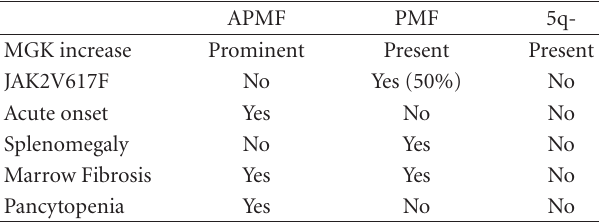
Table 1: The basic characteristics that help in the di ff erential diag- nosis of APMF (acute panmyelosis with myelofibrosis), PMF (primary myelofibrosis), and the 5q-syndrome according to the recent WHO classification